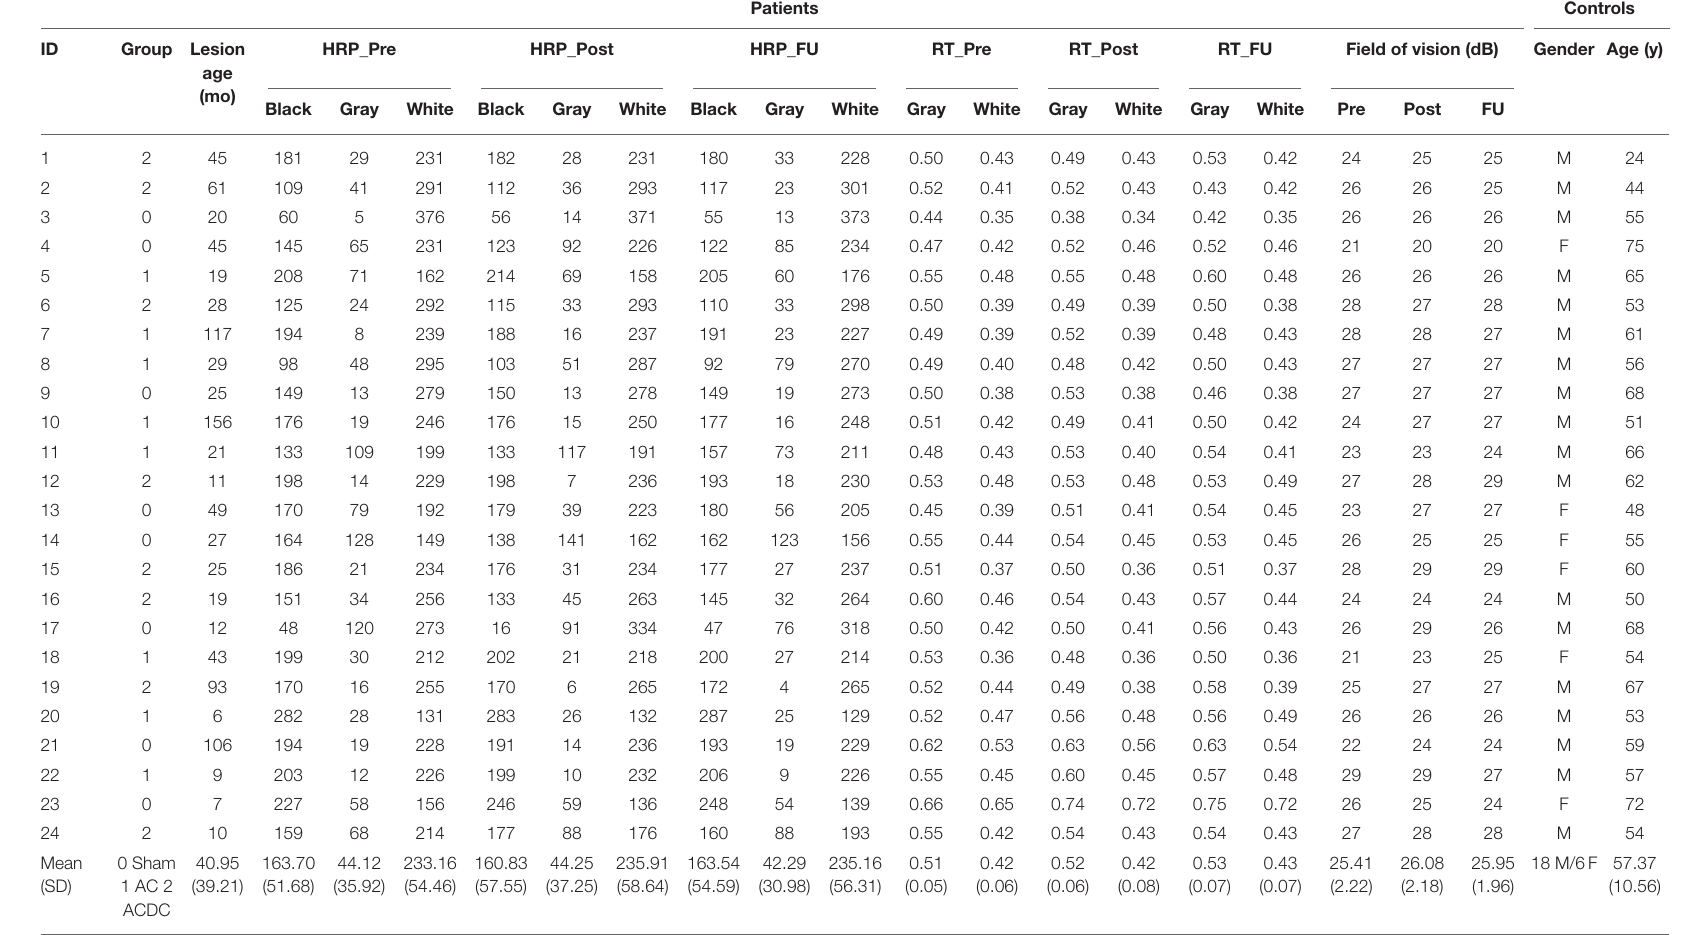
Gender: M, male; F, female; lesion age: the months since stroke happened; RT, reaction time; Pre, before treatment; Post, after treatment; FU, follow-up; ACDC, rtDCS/rtACS; AC, sham/rtACS; Sham,